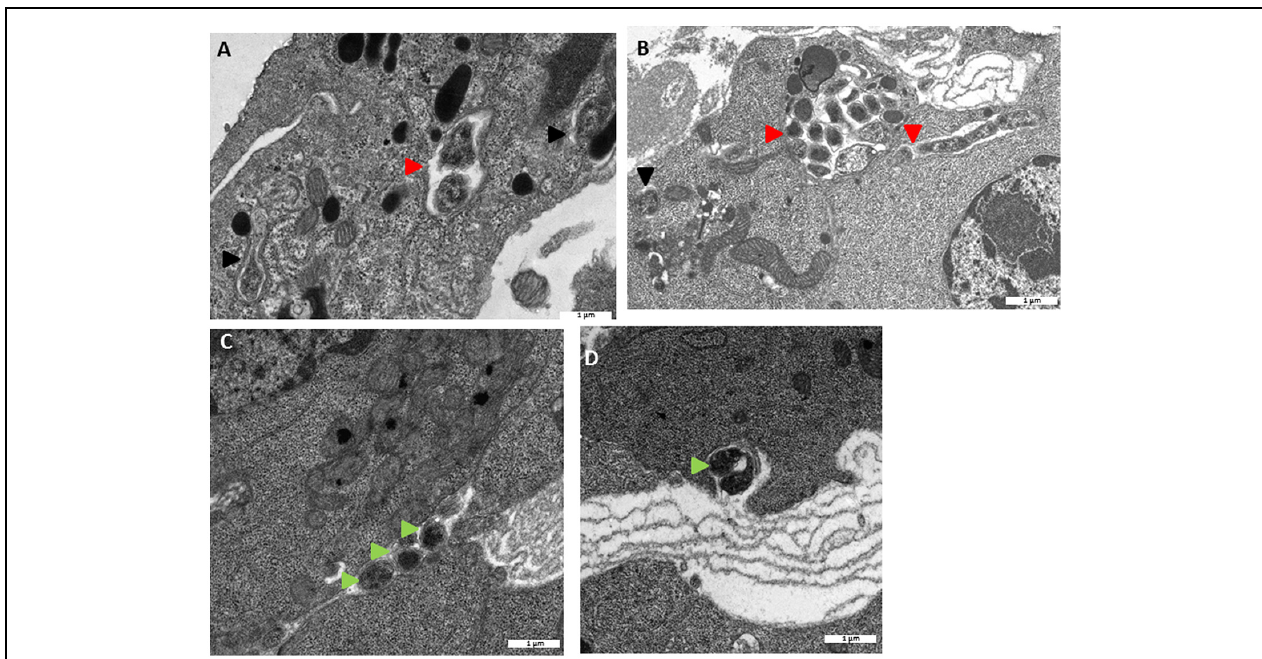
FIGURE 5 | Transmission electron microscopy observations of Wolbachia intracellularly (A,B) and extracellularly (C,D) in originally asymbiotic HOs 60 days post transplantation. (cid:2) Wolbachia (cid:2) Wolbachia dividing, (cid:2) Extracellular Wolbachia.